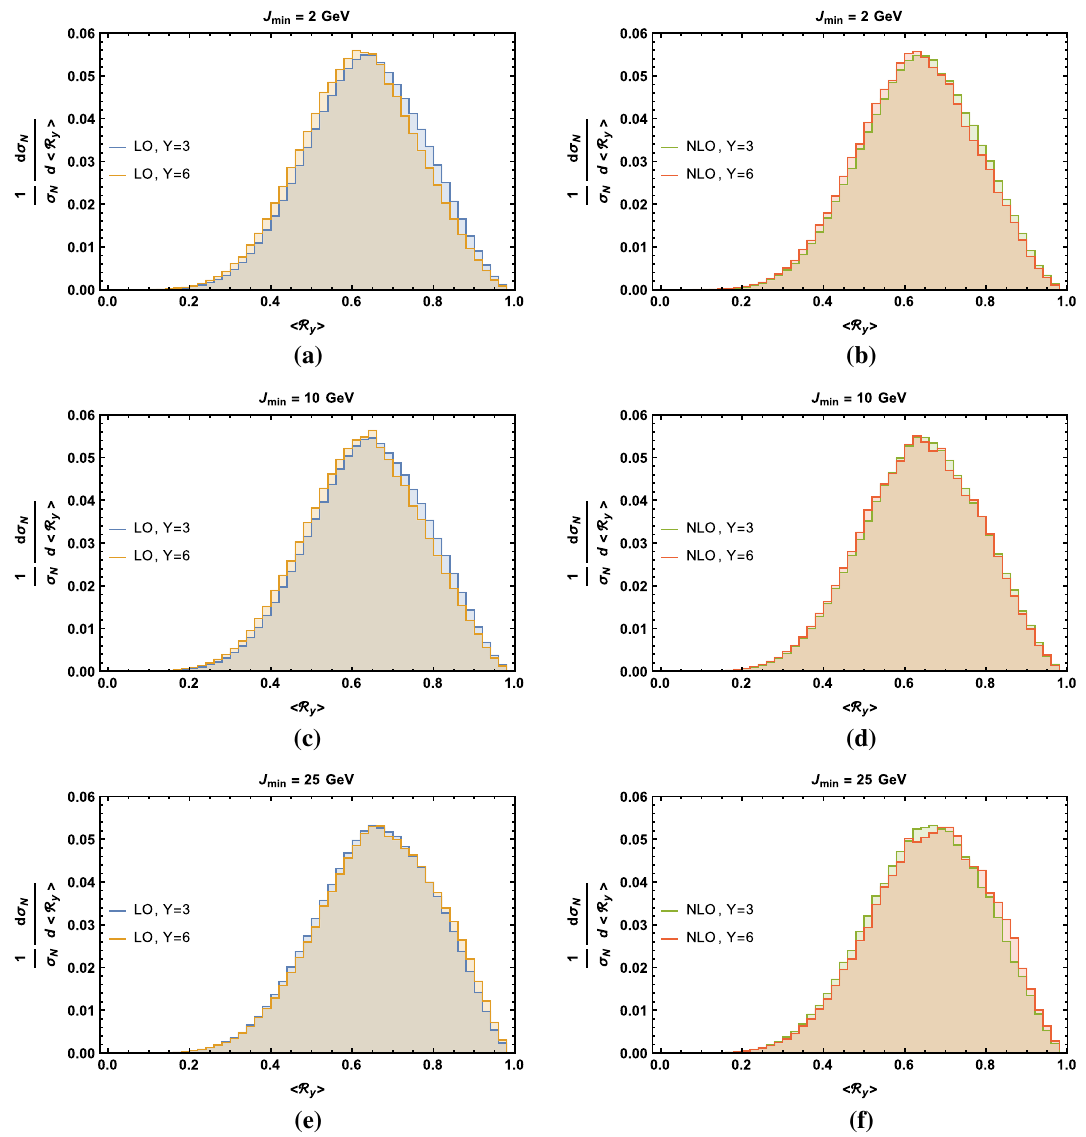
Fig. 3 Normalized (cid:10) R y (cid:11) at LO (left) and NLO+DLs (right) for multiplicity N = 4, rapidity difference Y = 3 , 6 and J min = 2 (top), J min = 10 (middle), J min = 25